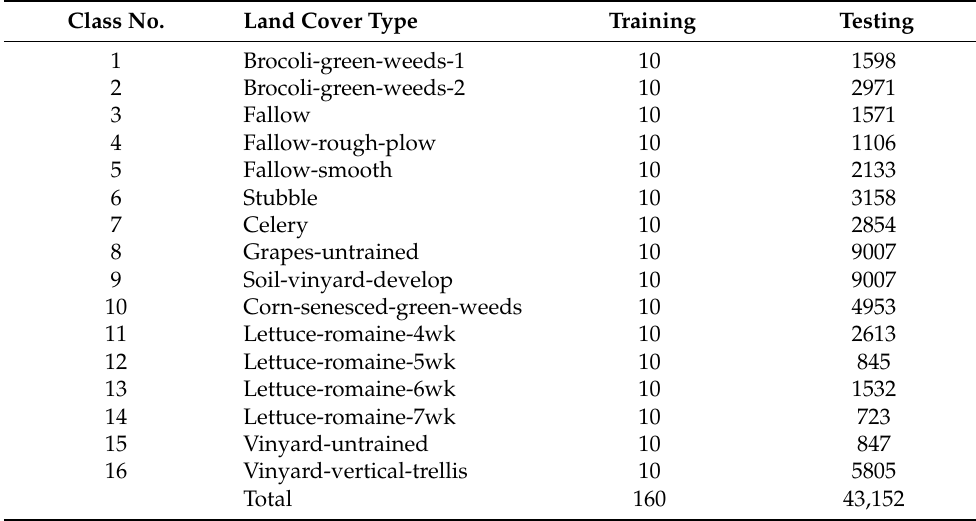
Table 3. The number of training, testing samples in the Salinas dataset. Class